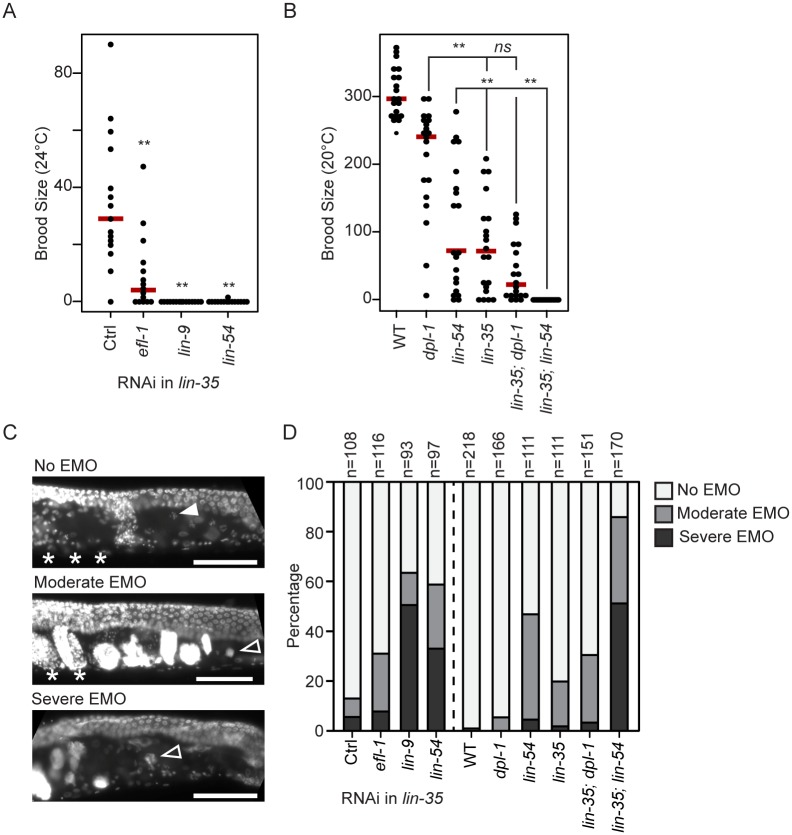
Phenotypic effects of depletion of MuvB or E2F-DP in lin-35 null worms.(A,B) Strip chart of the brood size of (A) lin-35 null worms following efl-1, lin-9, or lin-54 RNAi at 24°C and (B) wild-type (WT), single DRM mutants, and double DRM mutants at 20°C. Each dot indicates the total brood of an individual worm, and a red bar indicates the median for each genotype. Significance (** p-value < 0.01) was determined by a Wilcoxon-Mann-Whitney test comparing RNAi to empty vector control (Ctrl, A) or double mutants to their respective single mutants (B). (C) DAPI staining of young adults. The filled arrowhead indicates a representative healthy oocyte, open arrowheads indicate representative endomitotic oocytes (EMO), and asterisks indicate normal-appearing embryos. No EMO: no DAPI-stained DNA masses in the oviduct, and presence of normal-appearing embryos in the uterus. Moderate EMO: presence of some DAPI-stained DNA masses in the oviduct and some normal-appearing embryos in the uterus. Severe EMO: presence of DAPI-stained DNA masses in the oviduct and no normal-appearing embryos in the uterus. Scale bar, 50 μm. (D) Normalized stacked bar chart of the EMO phenotype of Day 1 adult lin-35 null worms with DRM subunit RNAi or double DRM mutants compared to single mutants and WT.